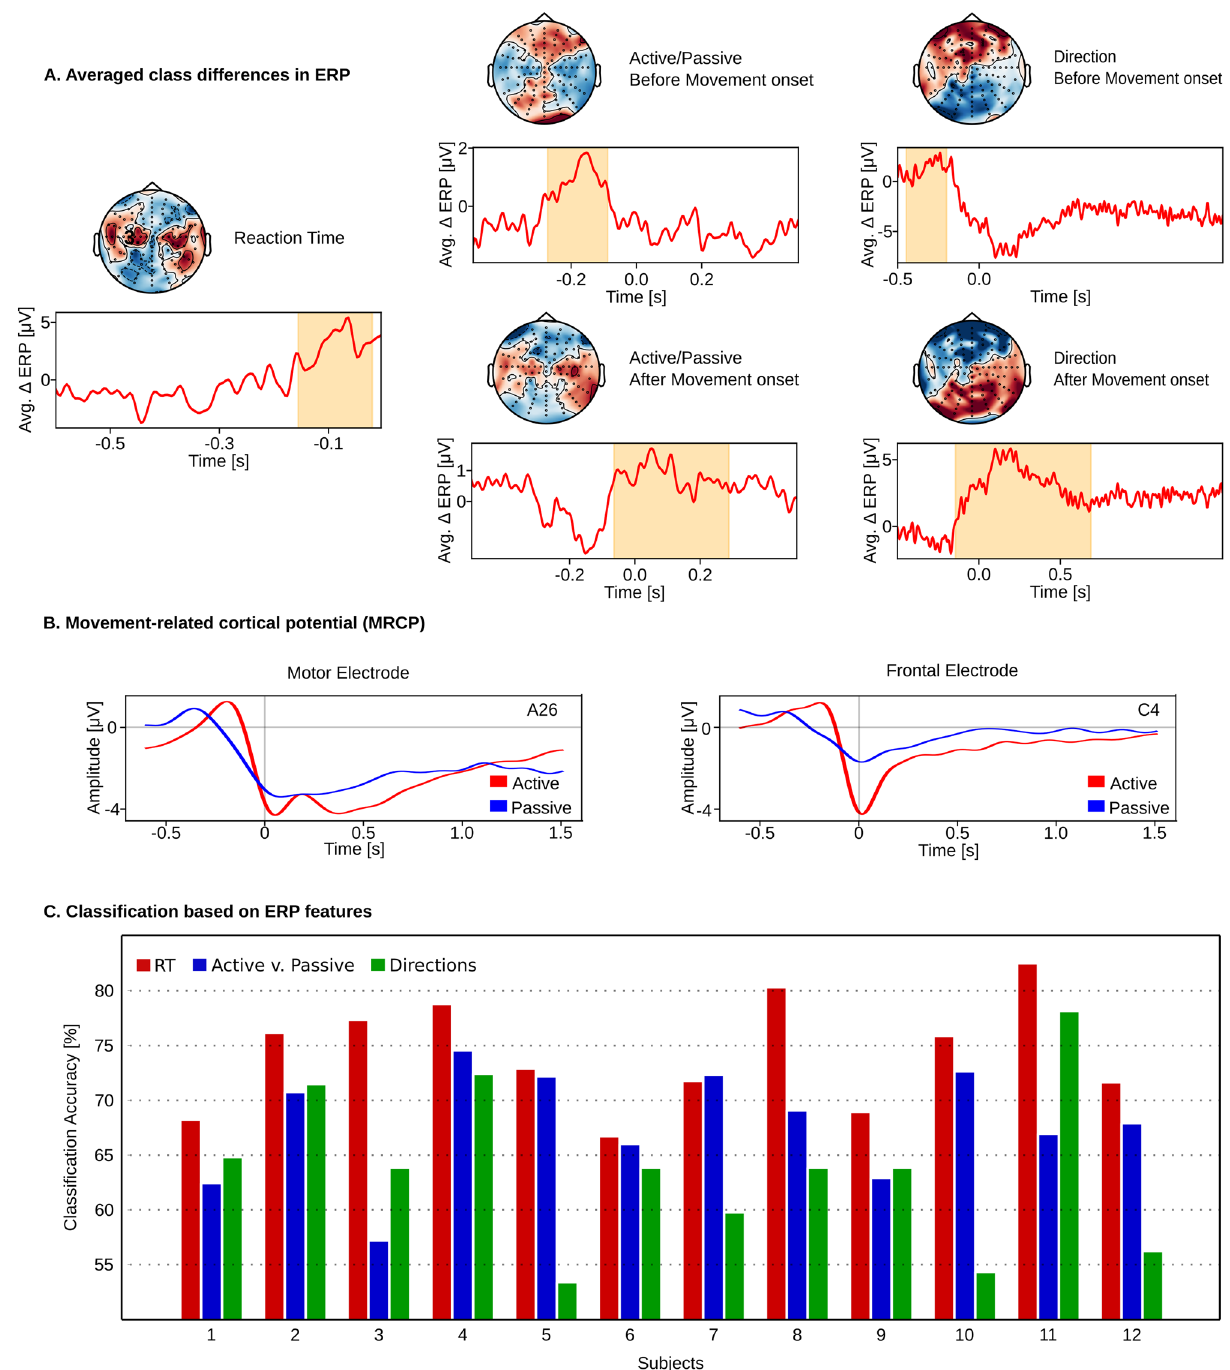
Figure 2. ( A ) Spatiotemporal cluster statistics on the EEG sensors revealed timing and location (channels) in which ERP differences between classes were significant for RT, active vs. passive, and directions. Curves were averaged across all subjects, and the yellow-shaded regions show significant time intervals. ( B ) MRCP from electrodes placed above the motor (A26) and frontal cortex (C4) showing negative potential that started at around 0.25 s before the movement. Curve averaged over all subjects. MRCPs for additional electrodes are shown in Supplementary Material (Fig. S1). ( C ) Leave-one-subject-out accuracies obtained using a logistic regression classifier on the raw EEG epochs for the three classification